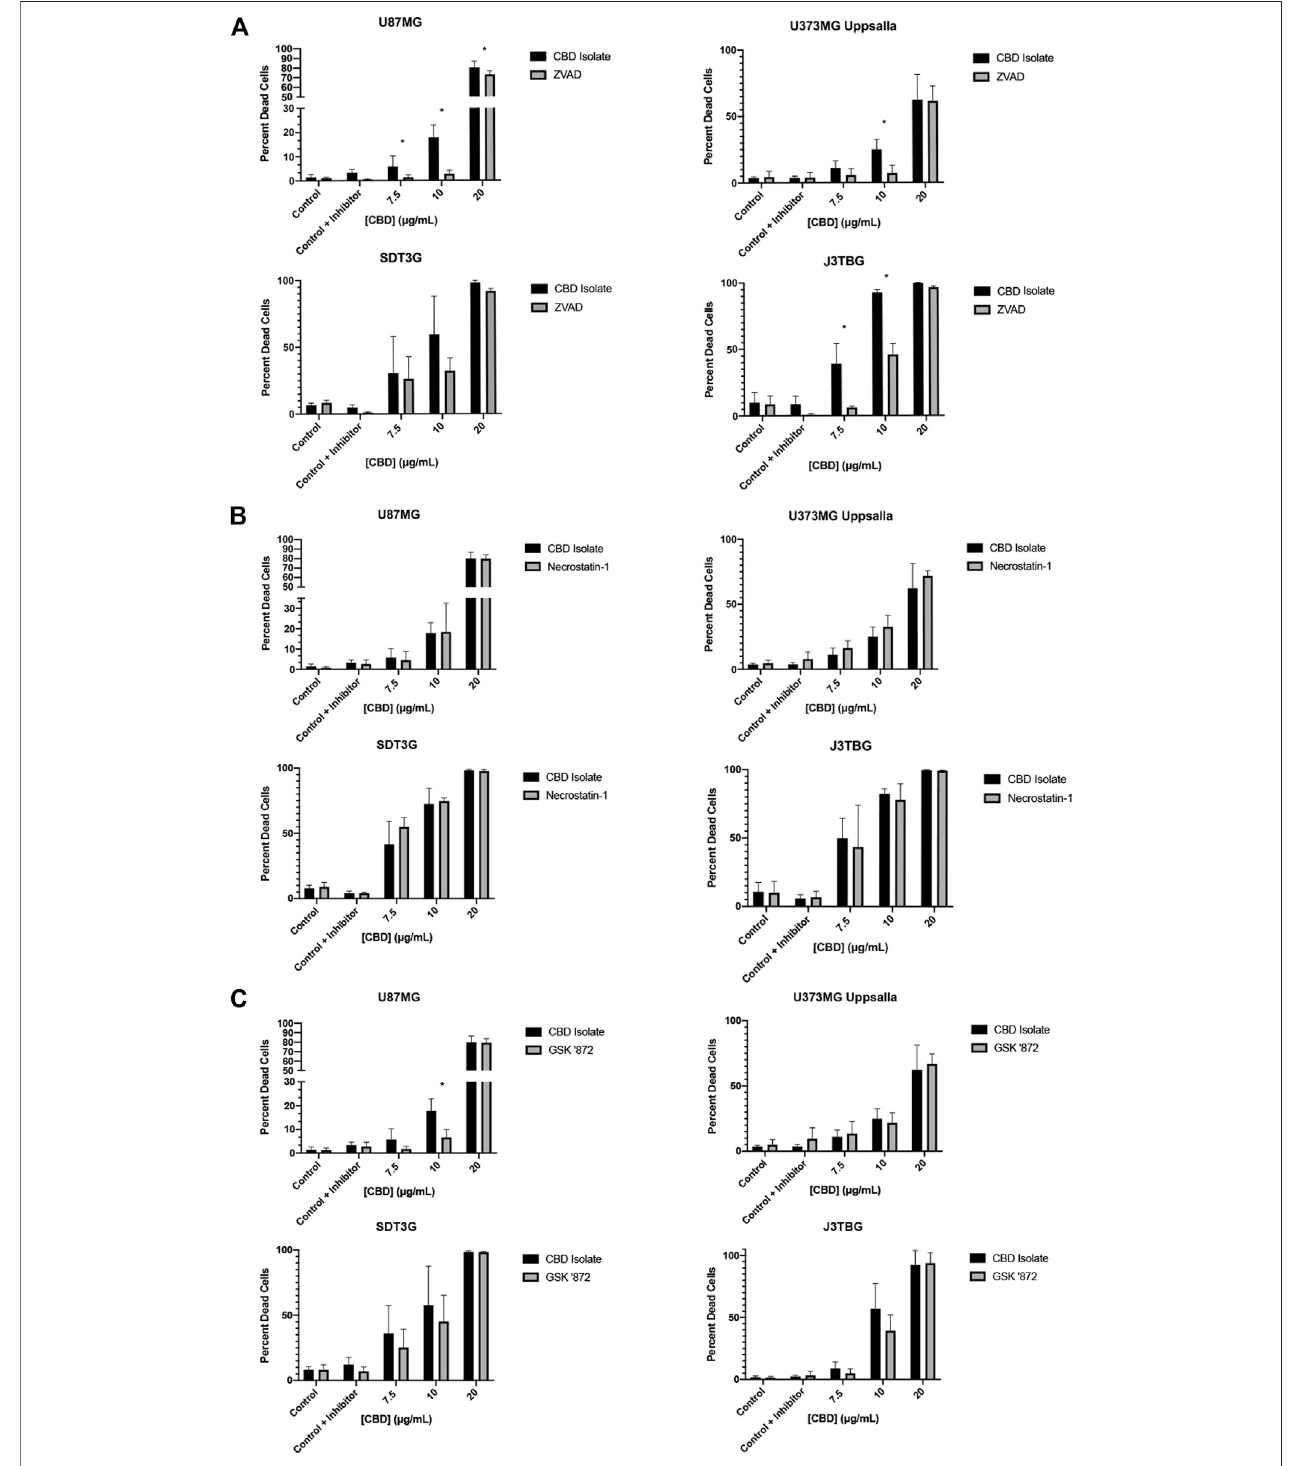
FIGURE 2 | CBD induces apoptosis with contribution from the protein kinase RIPK3. (A) U87MG, U373MG, J3TBG, and SDT3G glioma cells were treated with CBD isolate (0 – 20 μ g/ml) and zVAD (50 µM) concurrently for 96 h and cytotoxicity determined using the green fl uorescent dye, YOYO-1. Representative of n (cid:1) 3 independent experiments expressed as mean ± SD. *P (two-tailed t -test). U87MG: 7.5 (0.03), 10 ( < 0.001), 20 (0.03). U373MG Upsalla: 10 ( < 0.001). J3TBG: 7.5 ( < 0.001), 10 ( < 0.001), 20 ( < 0.001) (B) Cytotoxicity of glioma cells treated with CBD isolate (0 – 20 μ g/ml) and necrostatin-1 (100 µM) concurrently for 96 h. Representative of n (cid:1) 3 independent experiments expressed as mean ± SD. (C) Cytotoxicity of glioma cells treated with CBD isolate (0 – 20 μ g/ml) and GSK ‘ 872 (1 µM) concurrently for 96 h. Data shown are from n (cid:1) 3 independently repeated experiments expressed as mean ± SD. *P (two-tailed t -test). U87MG: 10 ( < 0.001).